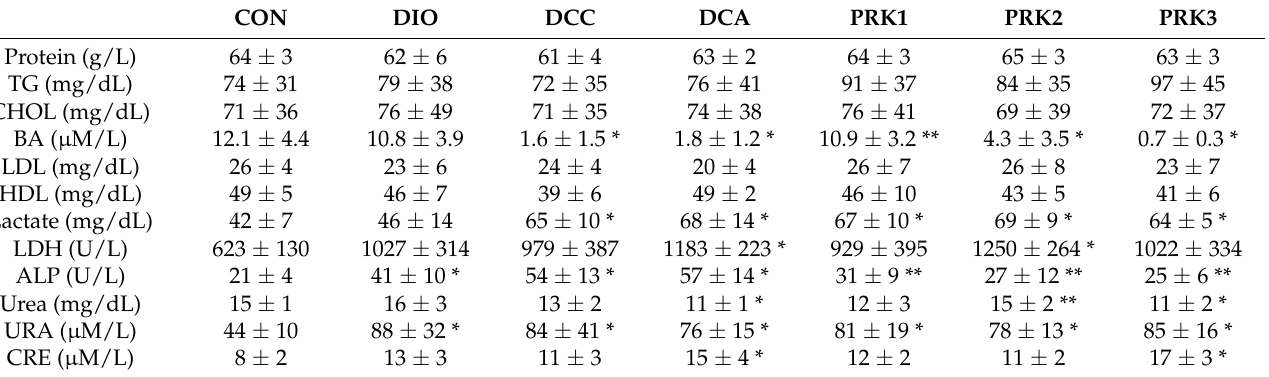
Table 2. Biochemical serum markers in Wistar rats at the end of the experiment ( n = 10 in each group). The results show mean values ± SD. *— p < 0.05 vs. CON group; **— p < 0.05 vs.